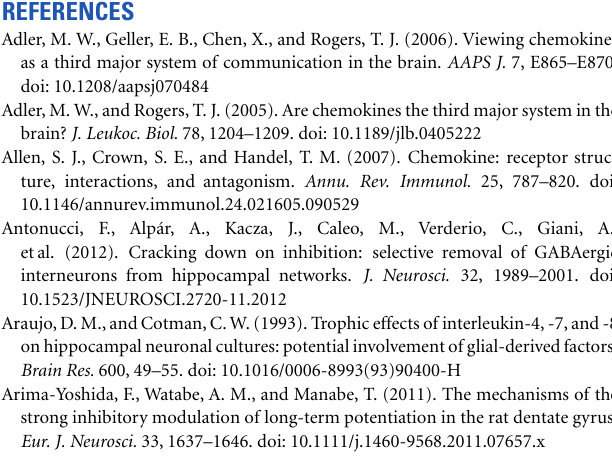
Figure S1 | Image analysis automation using EBImage software. (A) 40 × magnification of the apex of the hippocampal dentate gyrus. Green: CX 3 CL1; Red: NeuN and Blue: Hoechst. Scale bar = 50 μ m. (B) Hoechst channel alone. Stains cell nuclei. (C) NeuN channel alone. Labels neuronal cell bodies. (D) CX 3 CL1 channel alone. Labels CX 3 CL1 protein on dentate granule cells. (E) The blue fluorescence intensity was thresholded in order to select only Hoechst-stained nuclei (white). (F) Using a morphological kernel expansion algorithm, nuclei were dilated to select a cell soma region surrounding each nucleus. (G) A distance map was generated which calculates the distance each foreground (white) pixel is from the nearest background (black) pixel. (H) The watershed segmentation algorithm was then employed in order to separate all cell bodies from one another.The varying shades of gray in the image denote separated cells. Figure S2 | Effect of CX 3 CL1 on the peak glutamate-induced calcium response in organotypic slice cultures and mixed hippocampal cell cultures. (A) Shows the effect of CX 3 CL1 on glutamate-induced calcium influx in the CA1 region of organotypic hippocampal slices cultured for 21 DIV. Pre-treatment of slice cultures with CX 3 CL1 (500 pM) for 15 min prior to glutamate (30 μ M) exposure had no effect on the peak Ca 2 + fluorescence intensity achieved by each cell (Mann–Whitney U test; p < 0.001). (B) Shows the effect of CX 3 CL1 on glutamate-induced calcium influx in the CA1 region of organotypic hippocampal slices in the presence of picrotoxin. Pre-treatment of slice cultures with CX 3 CL1 (500 pM) and picrotoxin (100 μ M) versus picrotoxin alone (control) for 15 min prior to glutamate (30 μ M) exposure enhanced the peak Ca 2 + fluorescence intensity achieved by each cell (Mann–Whitney U test; p < 0.001). (C) Shows the effect of CX 3 CL1 (500 pM and 2 nM) on glutamate-induced calcium influx in neuronal cell types within mixed hippocampal cell cultures. Pre-treatment of primary hippocampal cell cultures with the lower dose of CX 3 CL1 (500 pM) for 15 min prior to glutamate (30 μ M) exposure had no effect on the peak Ca 2 + fluorescence intensity achieved by each neuronal cell (Kruskal–Wallis ANOVA and Dunn’s multiple comparisons post hoc tests; p < 0.001).The higher dose of CX 3 CL1 (2 nM), however, attenuated the peak Ca 2 + fluorescence intensity achieved by neurons in response to glutamate application. (D) Shows the effect of CX 3 CL1 (500 pM and 2 nM) on glutamate-induced calcium influx in non-neuronal cell types within mixed hippocampal cell cultures. Pre-treatment of primary hippocampal cell cultures with the lower dose of CX 3 CL1 (500 pM) for 15 min prior to glutamate (30 μ M) exposure had no effect on the peak Ca 2 + fluorescence intensity achieved by each non-neuronal cell (Kruskal–Wallis ANOVA and Dunn’s multiple comparisons post hoc tests; p < 0.001).The higher dose of CX 3 CL1 (2 nM), however, attenuated the peak Ca 2 + fluorescence intensity achieved by